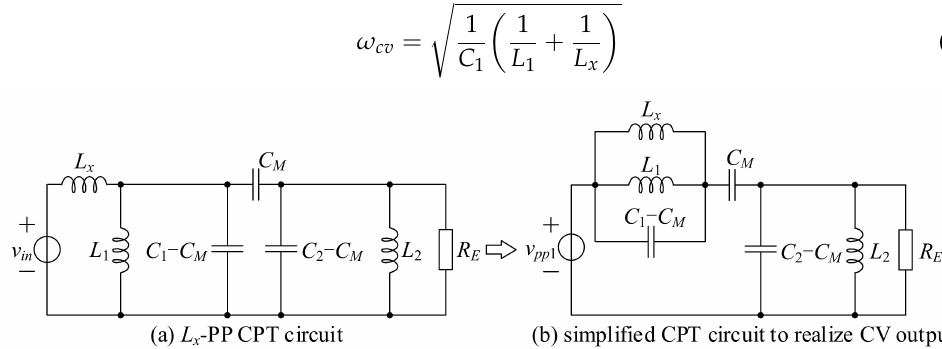
Figure 10. The L x -PP CPT circuit and its equivalent